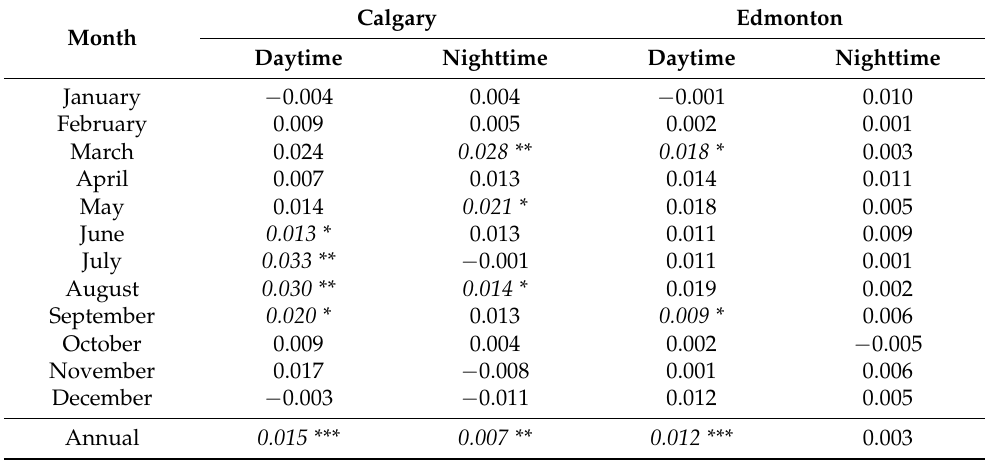
Table 1. Monthly and annual day and nighttime SUHI trends (°C/yr) during 2001–2020 in the cities of Calgary and Edmonton. The significant values are in italics, where *, **, and *** indicate the 90, 95, and 99% confidence levels, respectively.